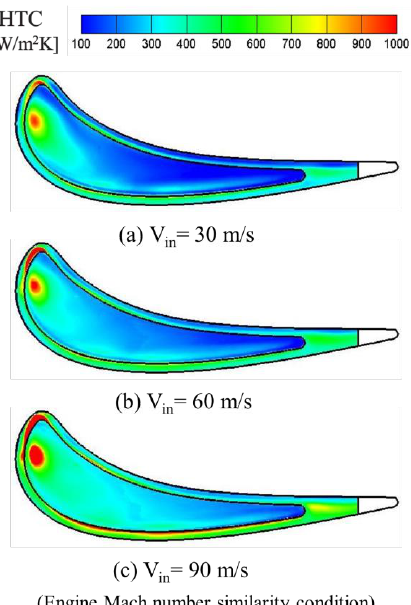
Figure 10. HTC contours of squealer tip.